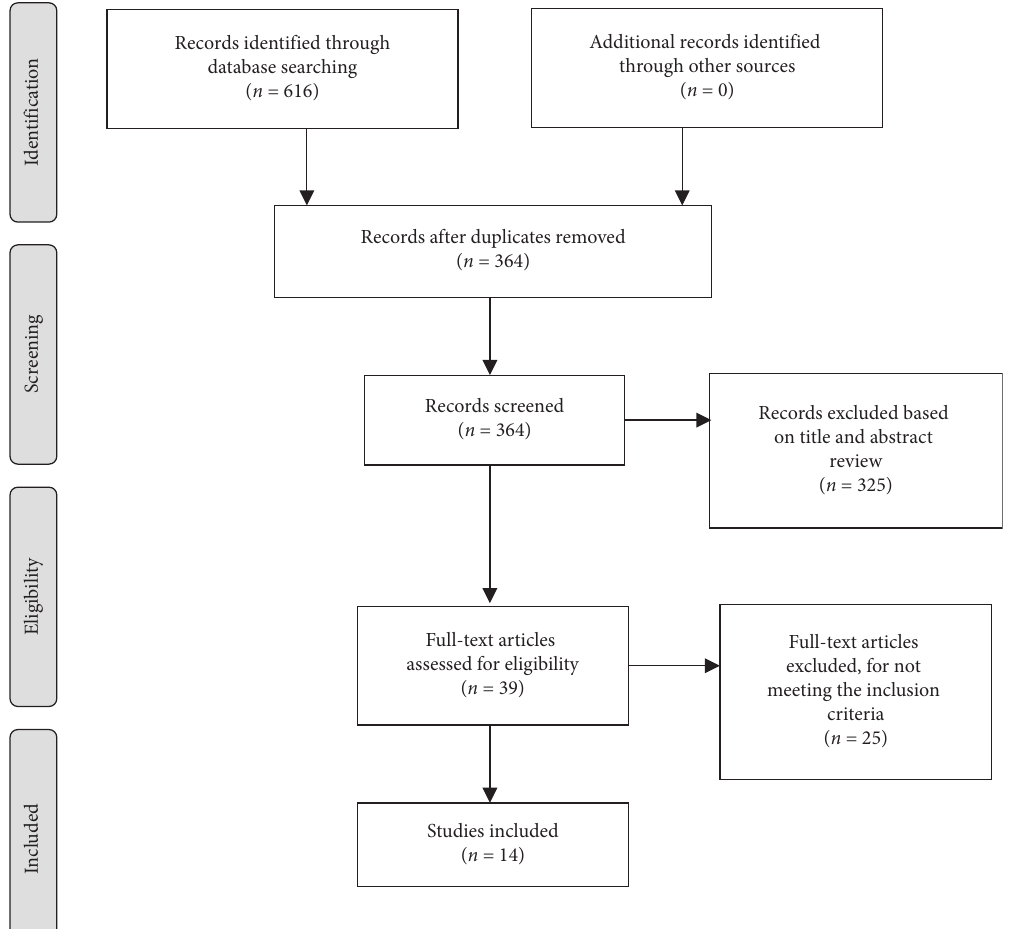
Figure 1: Literature search process—preferred items presented in the Joanna Briggs Institute Guidance